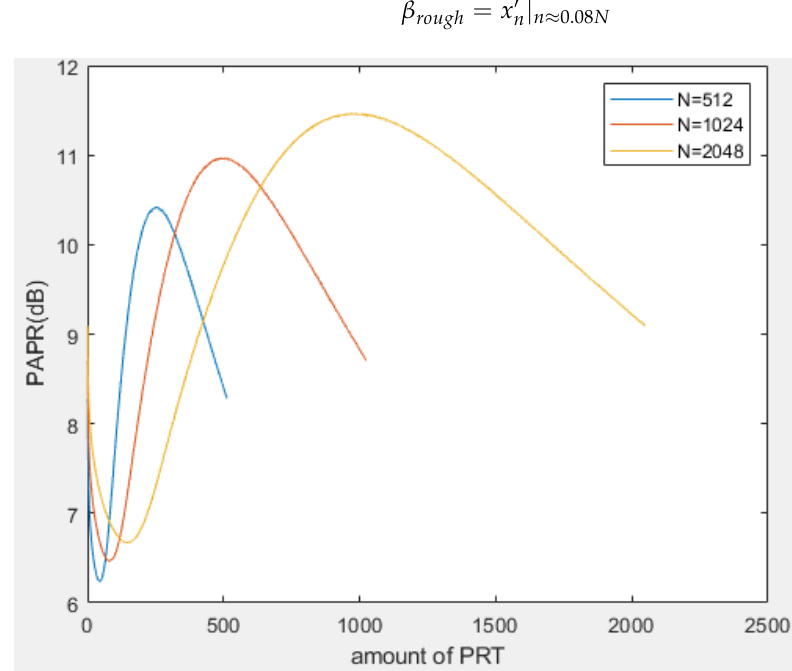
Figure 8. PAPR performance vs. amount of PRT for N = 512, 1024,